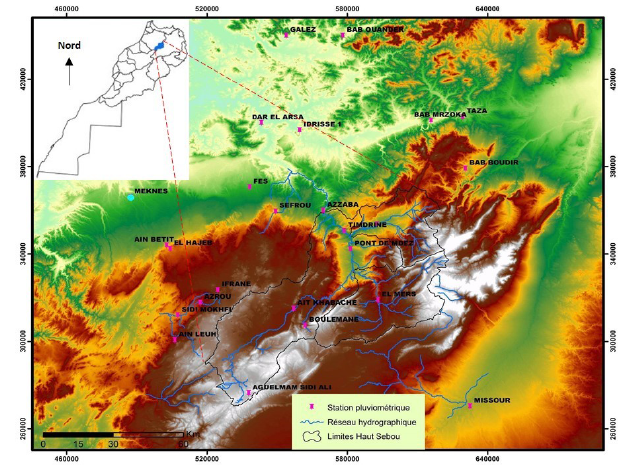
Figure 1. Localisation du bassin du Haut-Sebou.